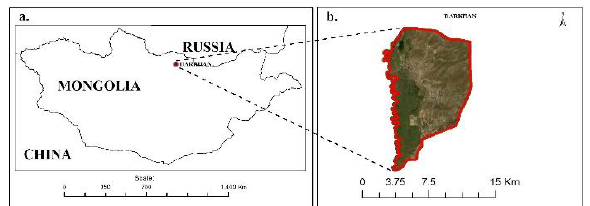
Figure 1. Map over the study area. (a) Location of Darkhan; (b) Map with a satellite